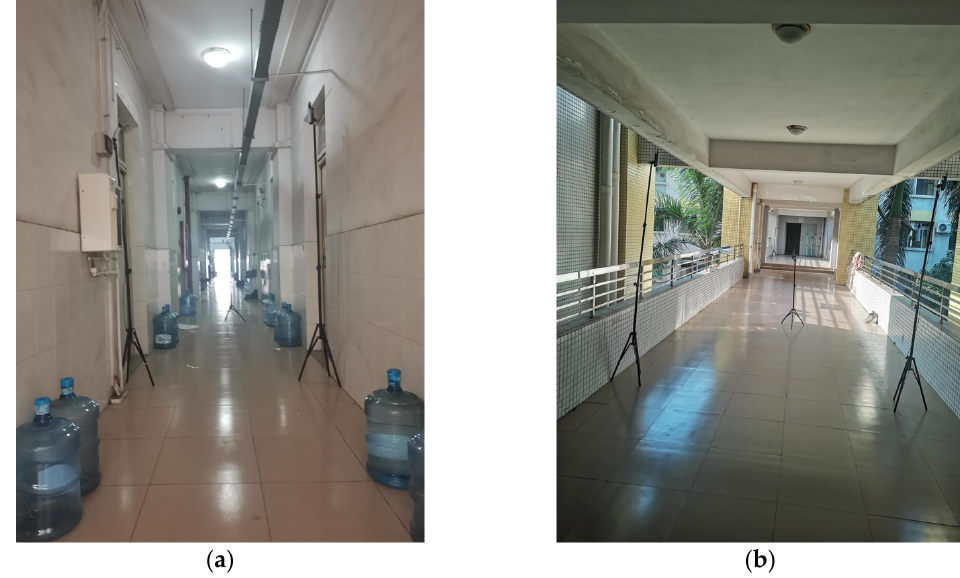
Figure 3. Experimental scene: ( a ) corridor; ( b ) connection of corridors.